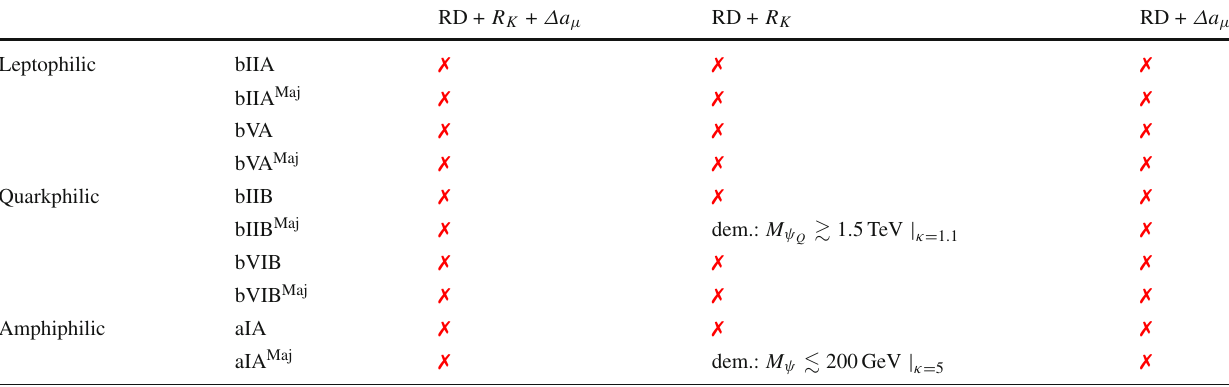
Table 4 We list the viable mass regions for various simultaneous solutions to relic density, R K and Δ a μ for each model under the premise of accordance with direct detection limits RD + R K + Δ a μ RD + R K RD + Δ a μ Leptophilic bIIA ✗ ✗ ✗ bIIA Maj ✗ ✗ ✗ bVA ✗ ✗ ✗ bVA Maj ✗ ✗ ✗ Quarkphilic bIIB